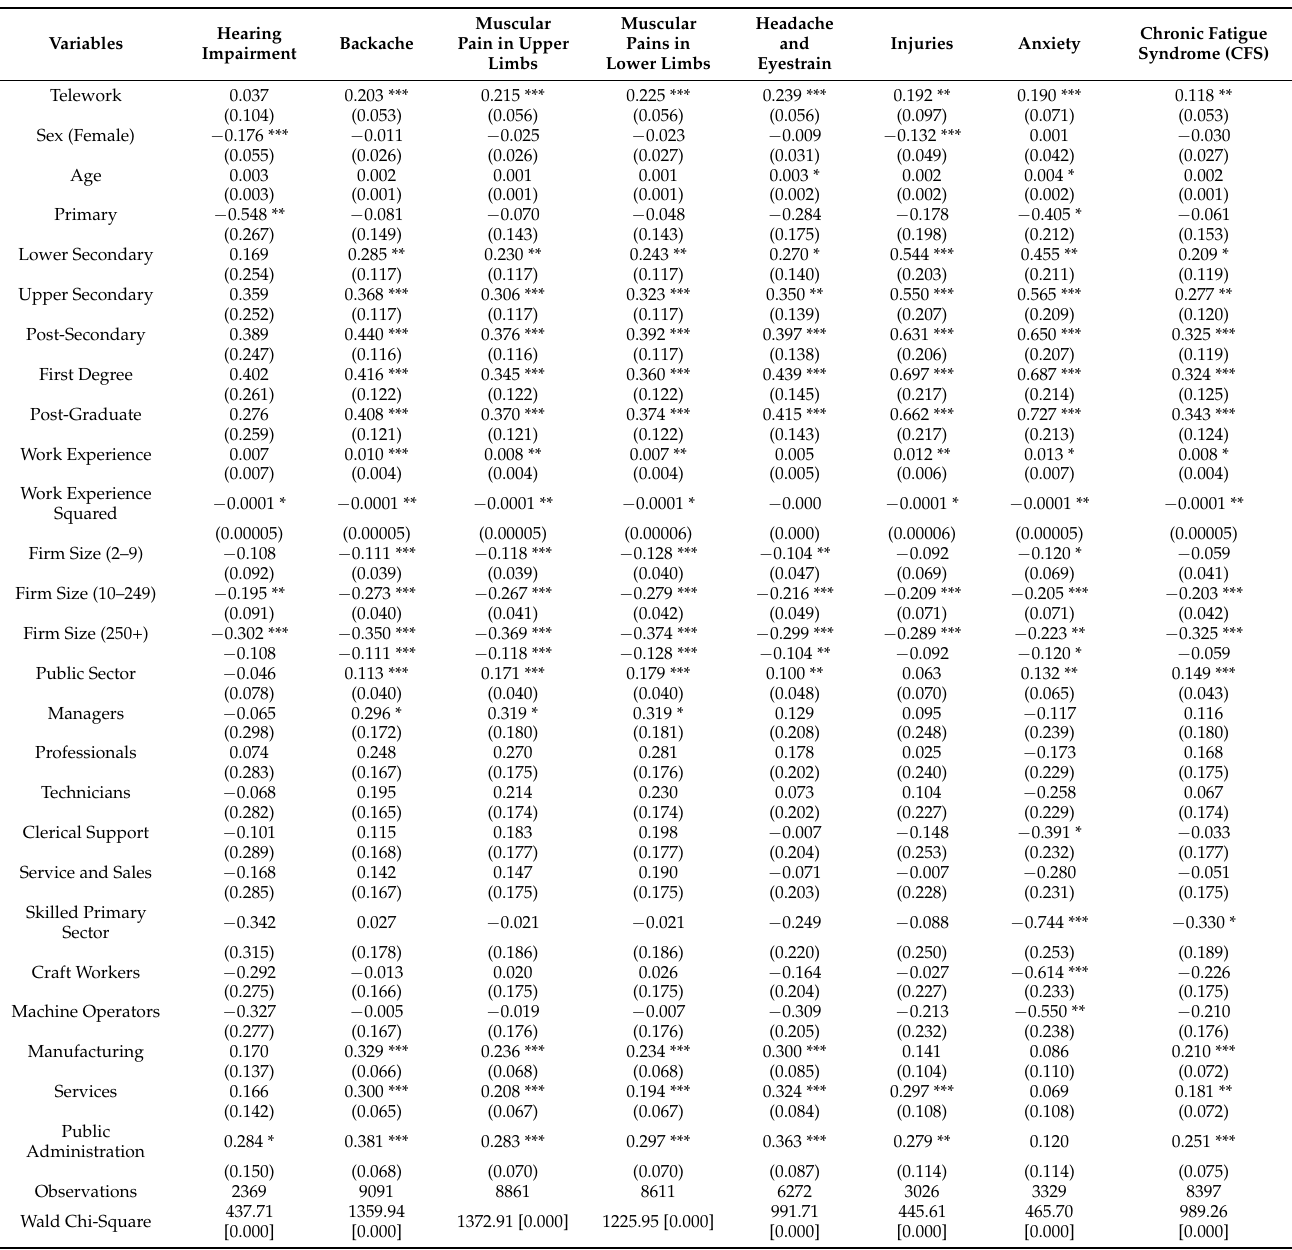
Table 3. Telework and Job Satisfaction for Workers with Disabilities and Health